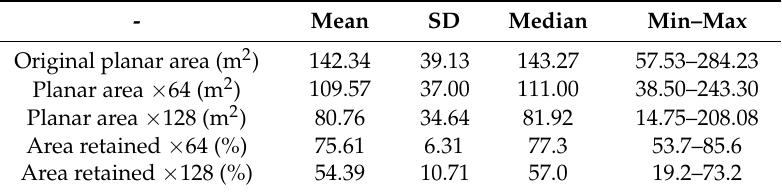
Table 3. Results of clipping digital elevation models (DEMs) with polygons, showing the mean, SD (standard deviation), median, minimum and maximum values of the planar areas of the original DEMs (original planar area), planar areas after the 64-cm aggregation (Planar area × 64), planar areas after the 128-cm aggregation (Planar area × 128), percent retention of planar areas after the 64-cm aggregation (area retained × 64), and percent retention of planar areas after the 128-cm aggregation (area retained ×